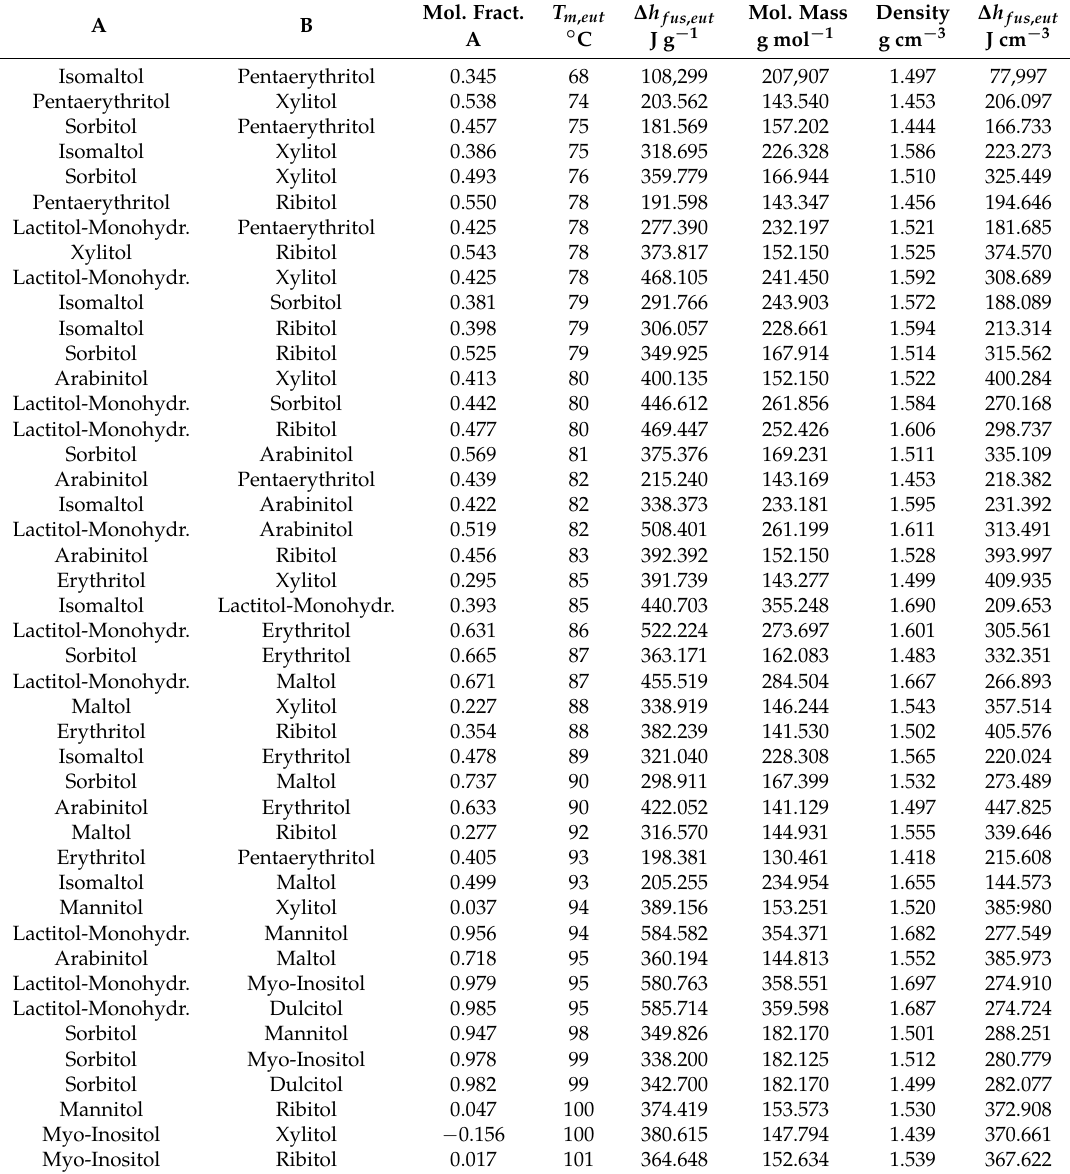
Table A1. Results from MATLAB script simulation of each combination of the selected sugar alcohols sorted by their melting